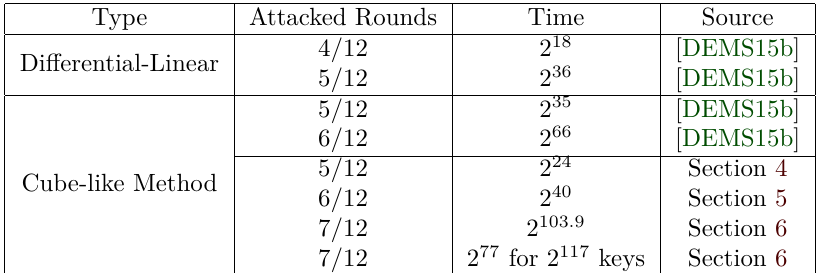
Table 1: Summary of Key-recovery Attacks on Ascon